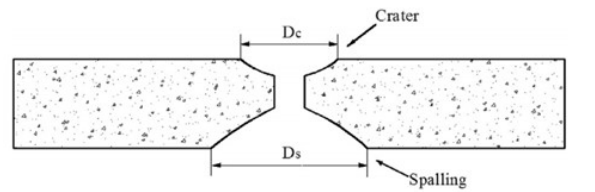
Figure 7-M easurement of the damaged areas